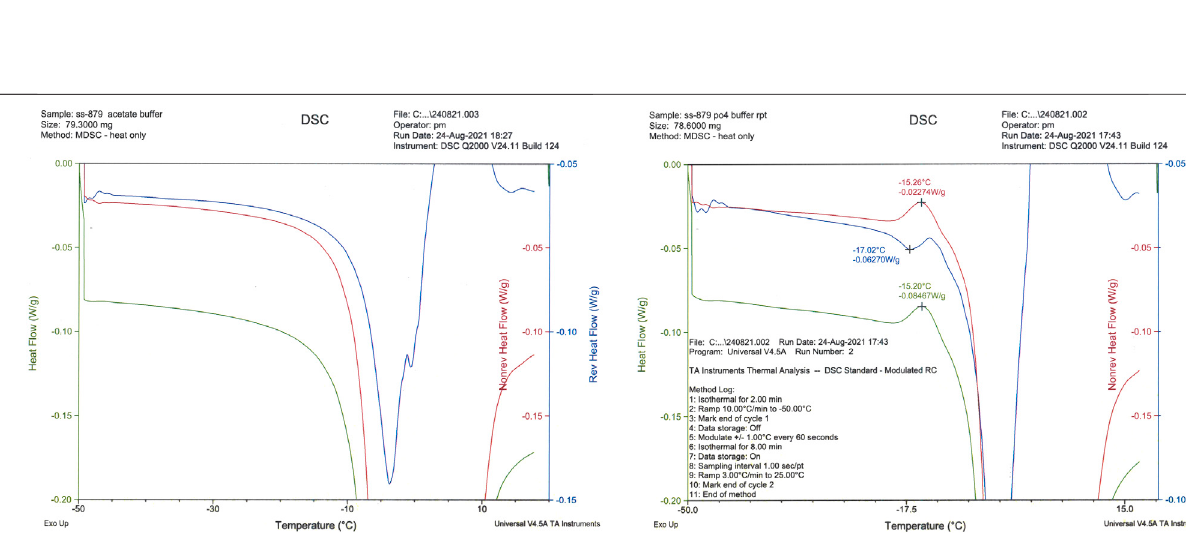
FIGURE 4 | Thermal analysis (mDSC) of sodium phosphate formulation with 0.9% w/v NaCl.